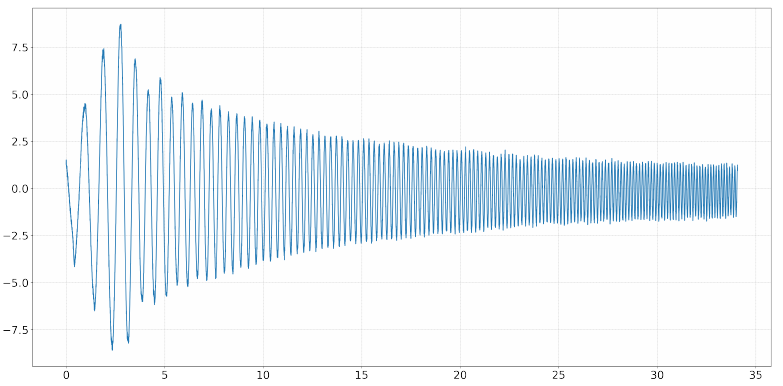
Figure 2. Floor excitation: X-axis angular velocity time